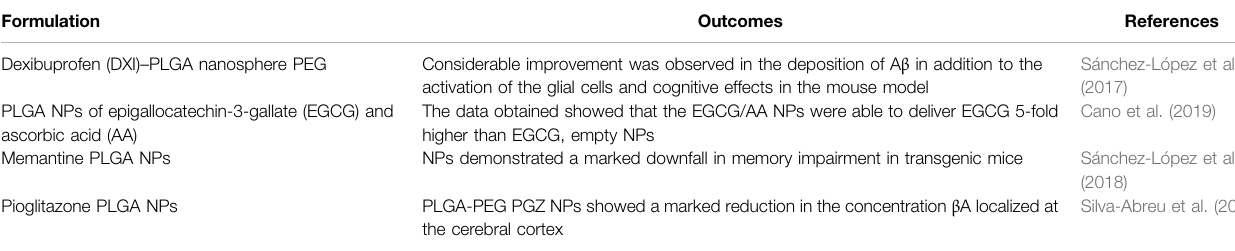
TABLE 2 | PNPs for drug targeting to the brain in Alzheimer ’ s disease.